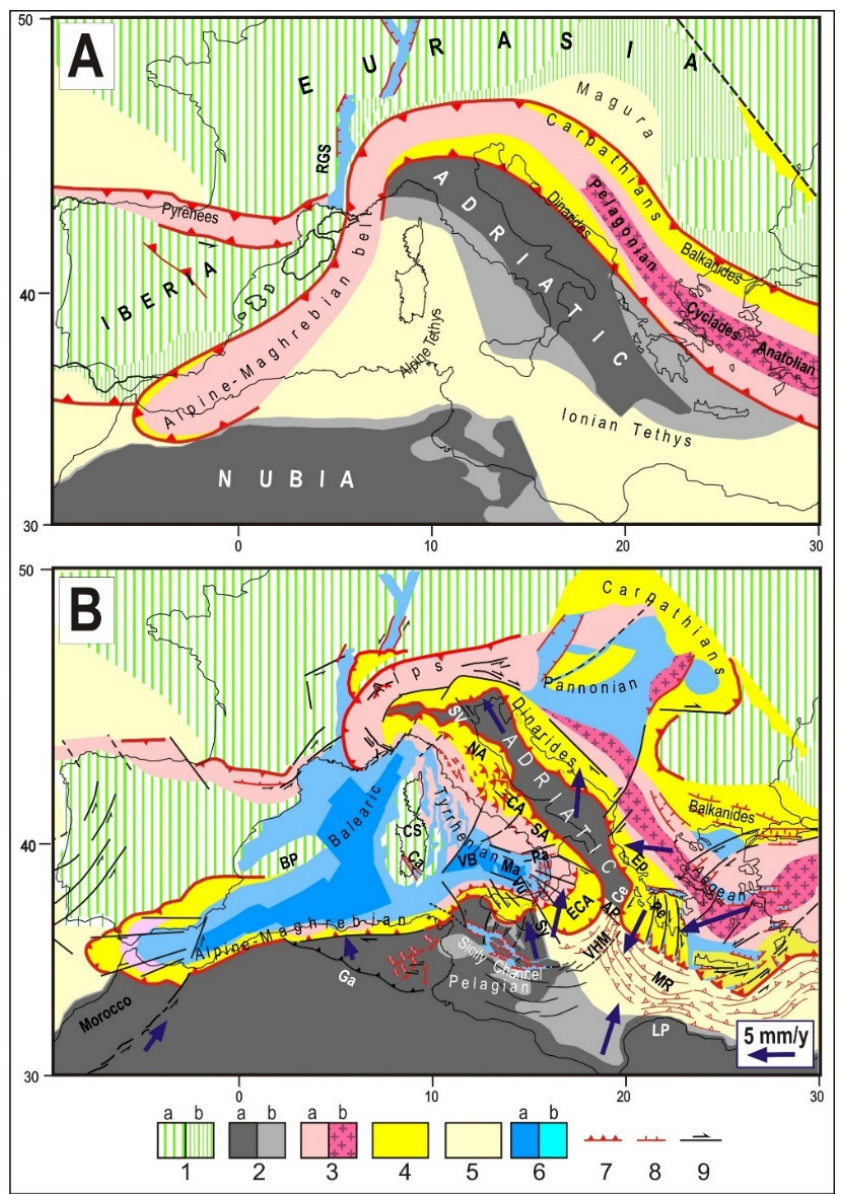
Figure 1. ( A ) Oligocene paleogeographic configuration. ( B ) Present tectonic setting. ( 1a,b ) Continental and thinned continental Eurasian domains. ( 2a,b ) Continental and thinned continental African/Adriatic domains ( 3a,b ) Tethyan belt, constituted by ophiolitic and metamorphic units and crystalline massifs ( 4 ) Other orogenic belts ( 5 ) Oceanic domains (eastern Alpine and Ionian Tethys) ( 6a,b ) Zones affected by intense or moderate crustal thinning ( 7,8,9 ) Compressional, tensional and strike-slip features. Ap = Apulian escarpment, BP = Balearic Promontory, CA = Central Apennines, Ca = Campidano graben, Ce = Cephalonia fault system; CS = Corsica-Sardinia block, ECA =